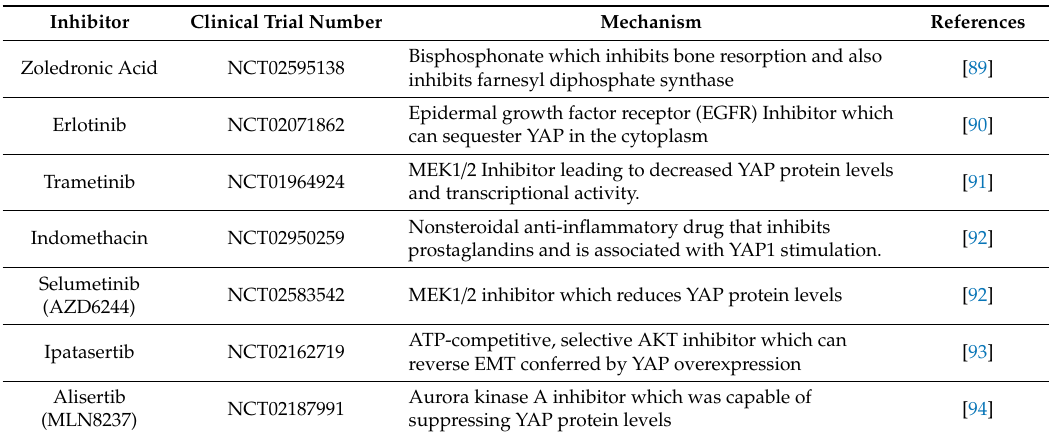
Table 2. Potential YAP Inhibitors Tested in Active TNBC Clinical